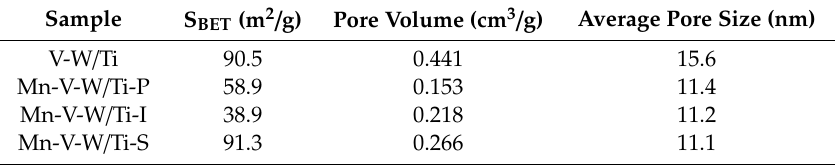
Table 2. The specific surface area, pore volume, and average pore size of the catalysts.